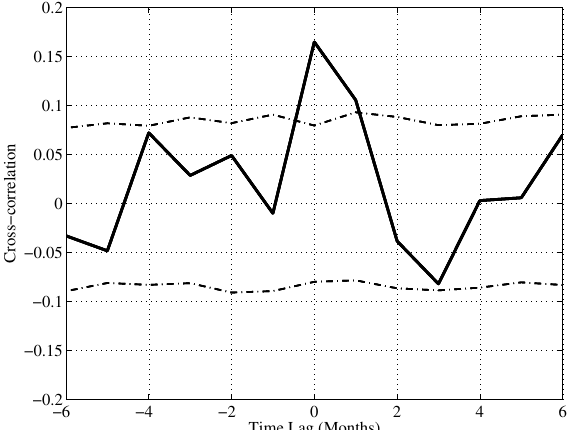
Fig . 5. – Cross correlation between second spatial variance eof mode time amplitude and the monthly nao index time series. significant positive correlation found at time lag τ = 0. Confidence bounds at 95% obtained through